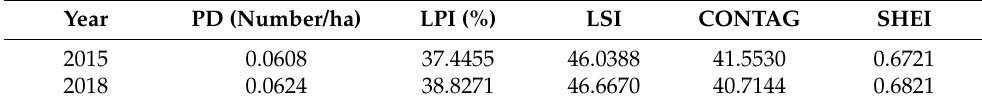
Table 3. Overall landscape pattern metrics for the Chengdu Plain urban